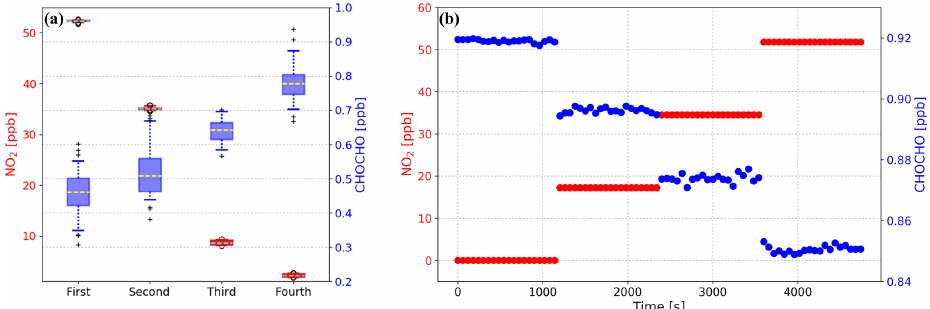
Figure 9. (a) The concentration of GLY is kept constant and mixed evenly with different concentrations of NO 2 four times. The concentration of GLY measured by IBBCEAS increased as that of NO 2 decreased, although only the NO 2 concentration was reduced manually. (b) A series of spectra with constant GLY concentration and increasing NO 2 concentration were simulated and then concentrations of GLY and NO 2 were calculated by retrieving these simulated spectra. The retrieved GLY concentration decreased with the increasing NO 2 concentration, although the set value of GLY concentration in the simulation was kept